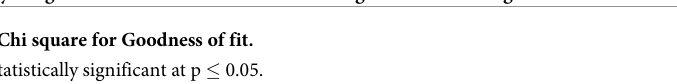
A statistical comparison was performed between satisfied and non-satisfied groups, and there were no significant differences as regard to age (p = 0.601), gender (p = 0.593), years of clinical practice (p = 0.620), and role amid the pandemic (p = 0.563). However, there was a sta- tistically significant difference regarding the role during online meetings, where “ mostly speak- ers ” reported more satisfaction compared to “ mostly attendees ” (p = < 0.001). Findings are summarized in Table 5 .